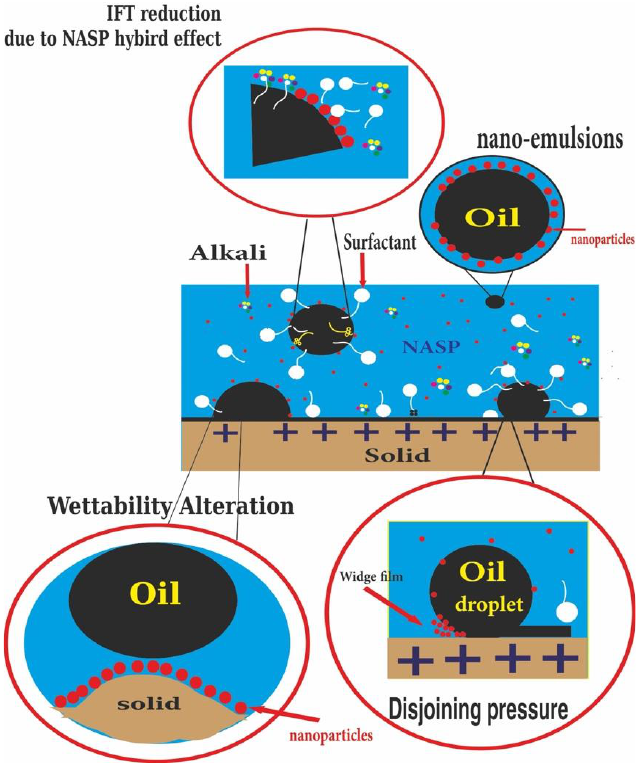
Figure 7. IFT reduction and wettability alteration by nanoparticles.